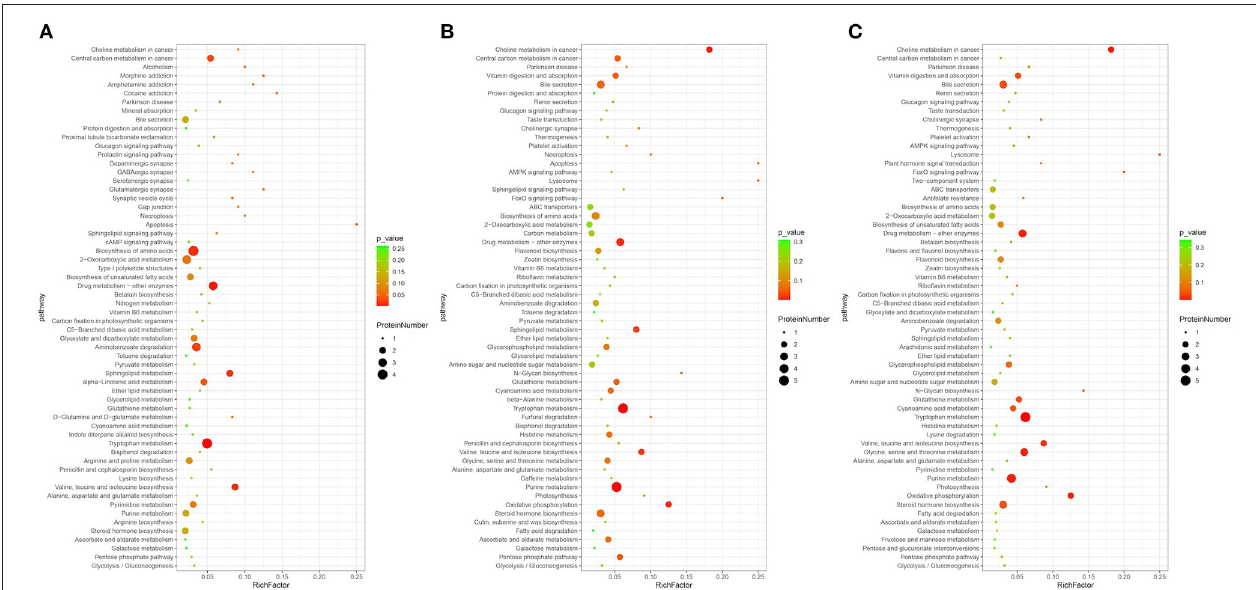
FIGURE 5 | Pathway enrichment analysis of differential metabolites: (A) Gansu vs. Guizhou, (B) Henan vs. Guizhou, and (C) Liaoning vs. Guizhou.